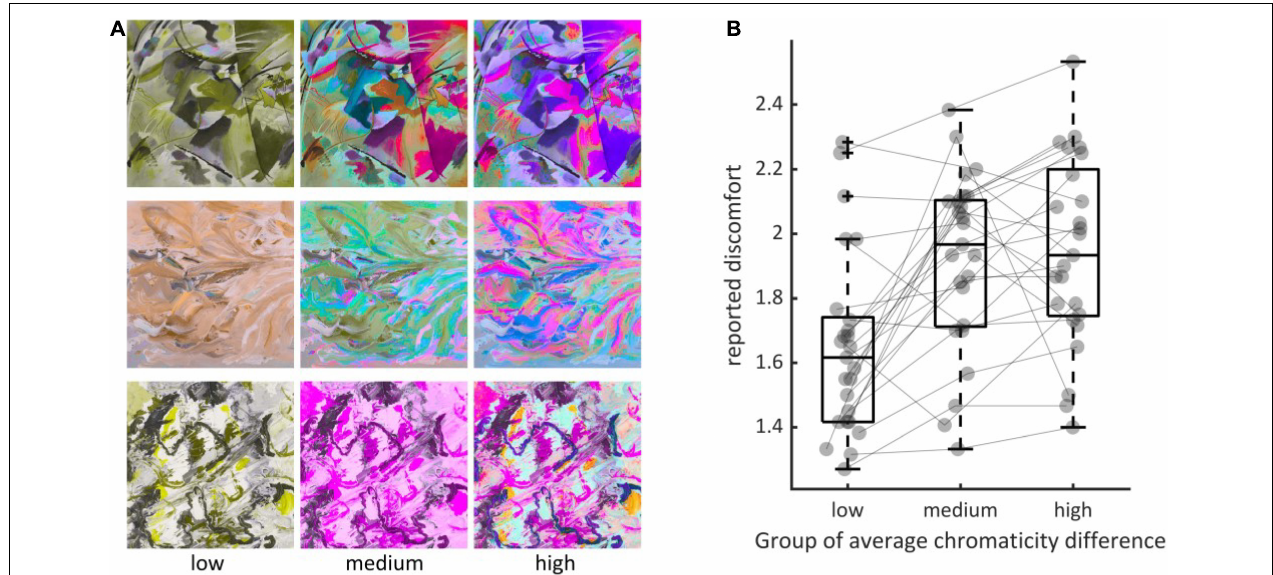
FIGURE 4 | (A) Examples of triples of stimuli (rows) showing the three levels of the metric (left column, “low,” middle, “medium” and right, “high”). (B) Distributions of average reported discomfort for the three groups defined by the three levels of average chromaticity difference, namely “low” ( N = 25, mean = 0.0035, std = 0.0009), “medium” ( N = 25, 0.0115, 0.0009) and “high” ( N = 25, 0.0190, 0.0018). Every dot represents the reported discomfort averaged over all observers in Experiment 3 when viewing an image with one of the three possible levels of the metric within each triple. The three elements making a triple are joined using the thin gray line. Jitter along the x-axis within each group has been added for visualization purpose. Boxplots display the median, the 25th and 75th percentiles (lower and upper hinges), the lowest measured values within Q1 (first quantile) and 1.5 × Q1 (lower whisker) and the highest observed value within Q3 (third quantile) and 1.5 × Q3 (upper